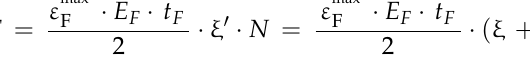
L d L d Figure 5. Fraction μ of μ’ that represents the effective height of the side-bonded fabric sheet, whereas the remaining part of μ’ is the anchorage (bond) length. The shadowed length L d + L d is the length of a fiber that crack opening causes to debond around the crack.